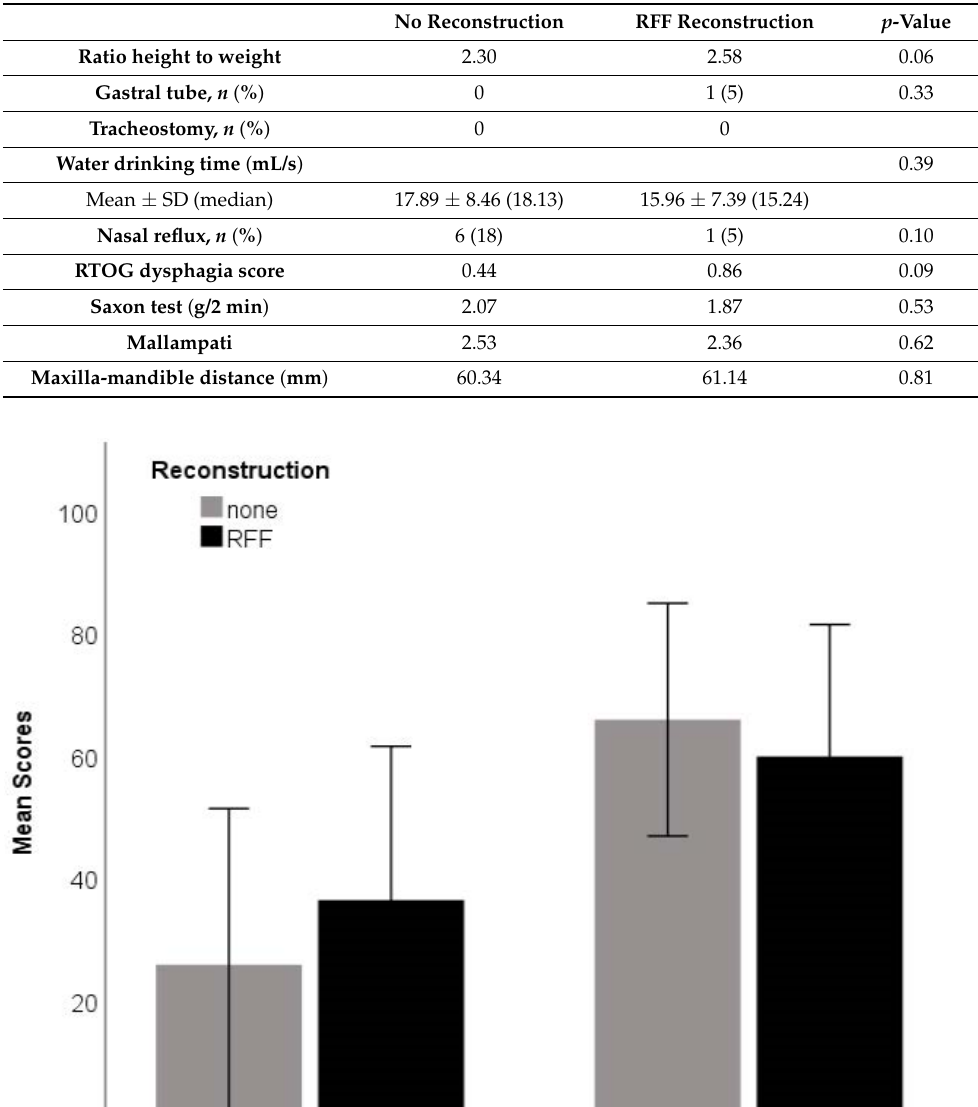
Table 7. Functional analyses.